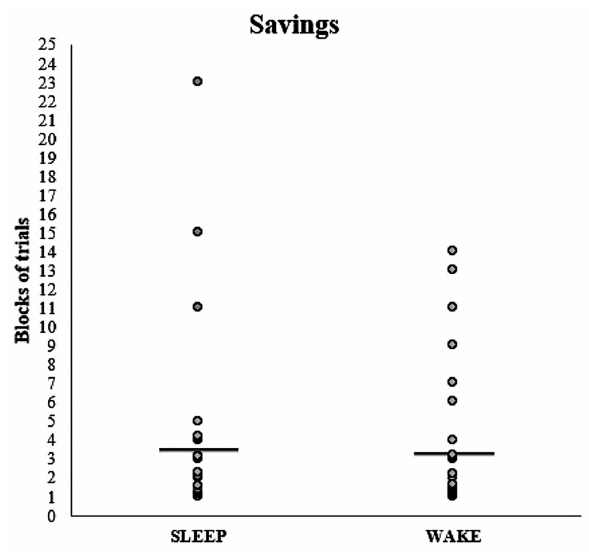
Figure 3 - Number of blocks during the relearning phase needed to achieve the post-test mean performance for each participant. Data show the mean (solid line) and individual data